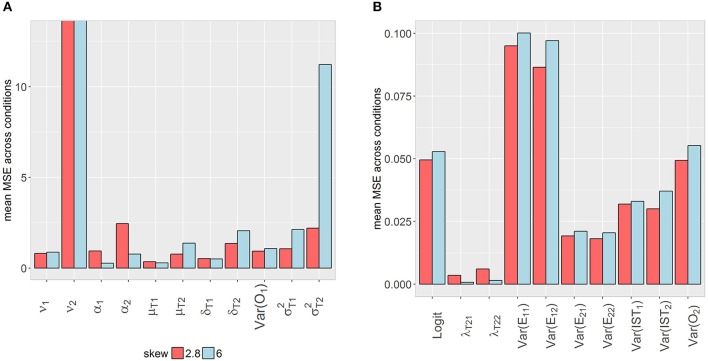
Average mean squared error (MSE) across conditions for the different parameters. The range of the y-axes differs between panel (A) displaying parameters with comparably high MSE values and panel (B) displaying parameters with comparably low MSE values. To compare the skewness conditions, the model with 3 occasions, 125 observations and δTc = 2.8 was eliminated for this visualization as a corresponding model with δTc = 6 was previously excluded from the analysis. The bars for ν2 were cut off in order to ensure visibility of the values for the other parameters (mean MSE for ν2 in conditions with δTc = 2.8 was 20,694; mean MSE for ν2 in conditions with δTc = 6 was 30,281). c = index for class; Ejc = residual variable; j = index for occasions; O = latent occasion-specific variable; ISTc = latent indicator-specific residual trait variable for the second indicator; Tc = latent trait variable; α2c = intercept of the second indicator; νc = degrees of freedom parameter; δTc = skewness parameter for Tc; λT2c = trait loading of the second indicator; μTc = location parameter for Tc; σTc2= scale parameter for Tc.